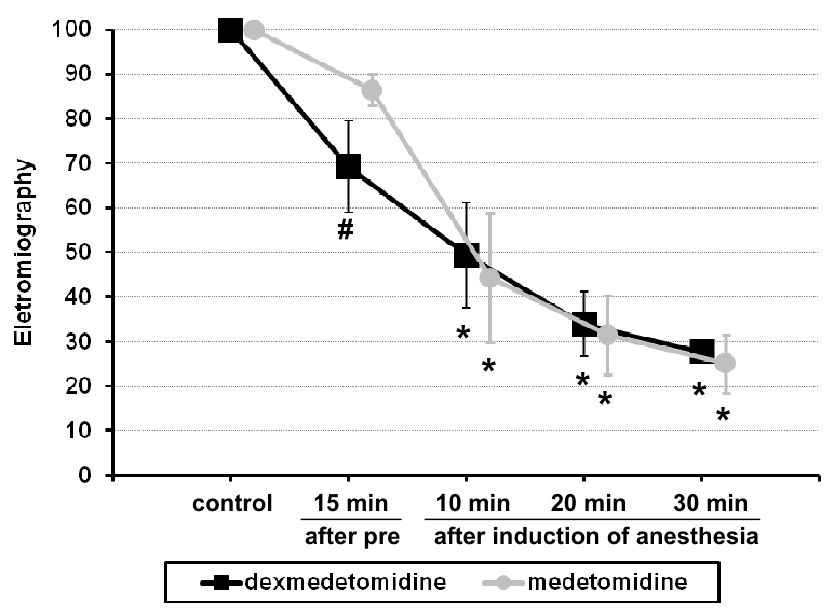
FIGURE 3 – Electromyography (EMG) of groups treated with dexmedetomidine (DEX) or medetomidine (MED) at the 5 times points * P<0.05: versus control at the same group; # P<0.05: DEX versus MED at the same time of observation; values as mean ± standard deviation; pre = preanesthetic